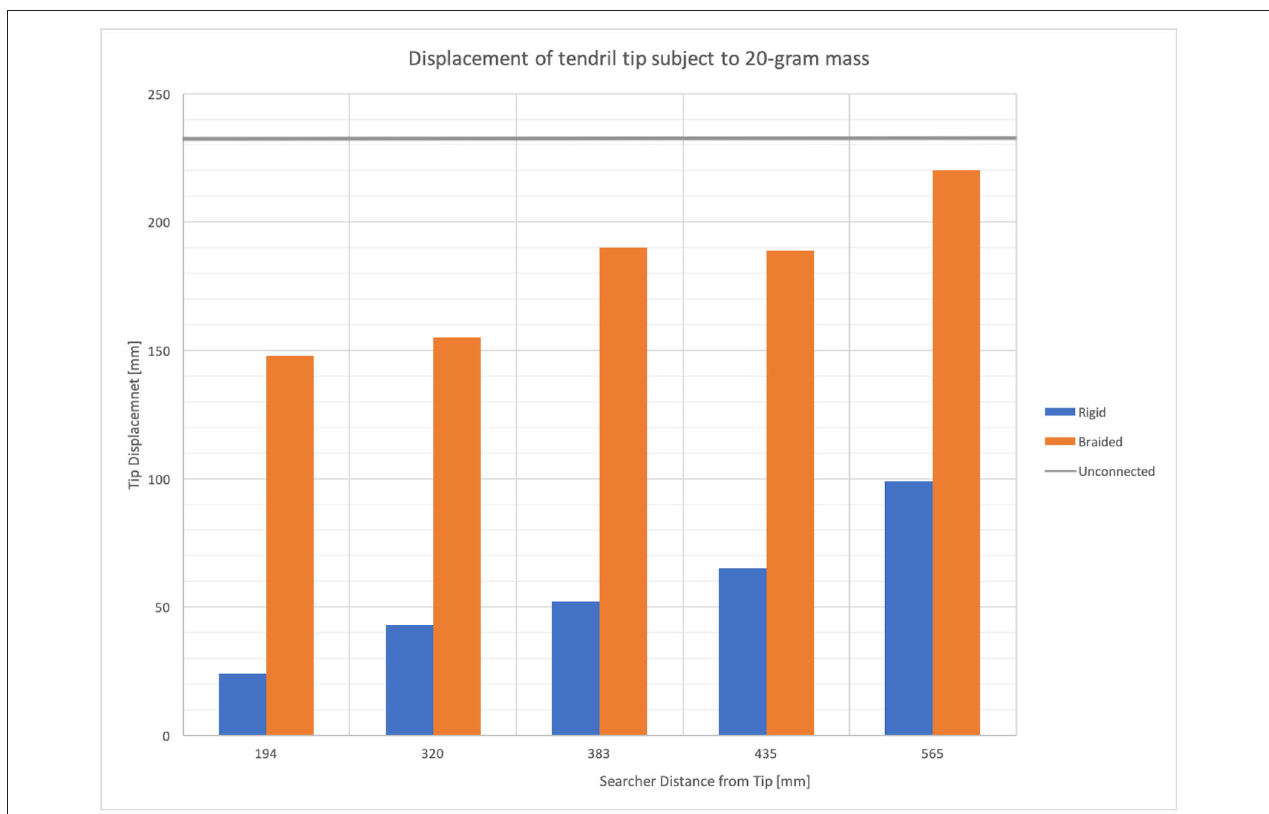
FIGURE 12 | Stem-tendril’s tip displacement when subjected to a 20-g mass at the tip. Comparison of displacements in cases where a searcher stem is connected at increasing distances (left to right) from the tip, to a rigid environmental object (blue bars), and when braided to a second stem-tendril (orange bars). Displacement when unconnected shown as gray horizontal